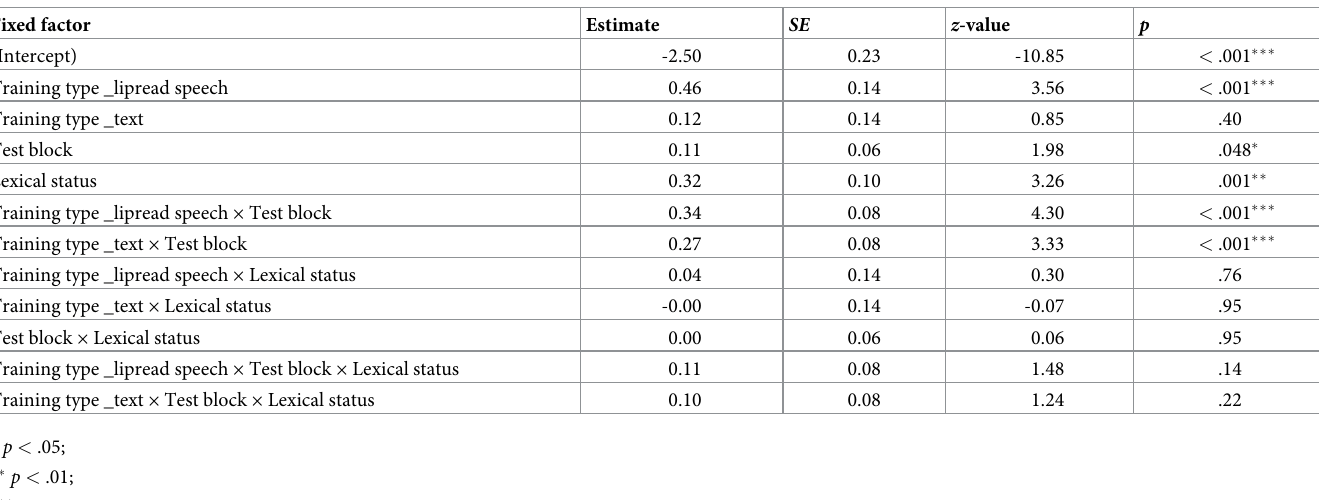
Table 1. Fixed effect coefficient estimates for the generalized linear mixed effects model fitted on the auditory-only test data. Correct ~ 1 + Training type × Test block × Lexical status + (1 | subject) + (1 | item). Fixed